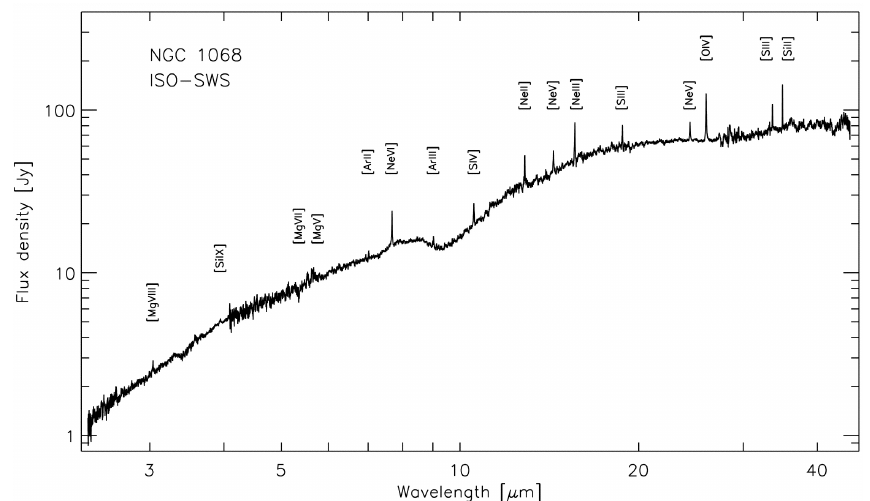
Figure 17. ISO-SWS spectrum of the obscured AGN NGC 1068 showing various high ionization potential atomic lines including [NeVI] at 7.6 µ m. This line was not studied with Spitzer since the low resolution of IRS at this wavelength was insufficient but shows considerable potential from the ISO spectra of NGC 1068 and Circinus [60,188]. Reproduced with permission from Lutz et al. [188], AAS © .